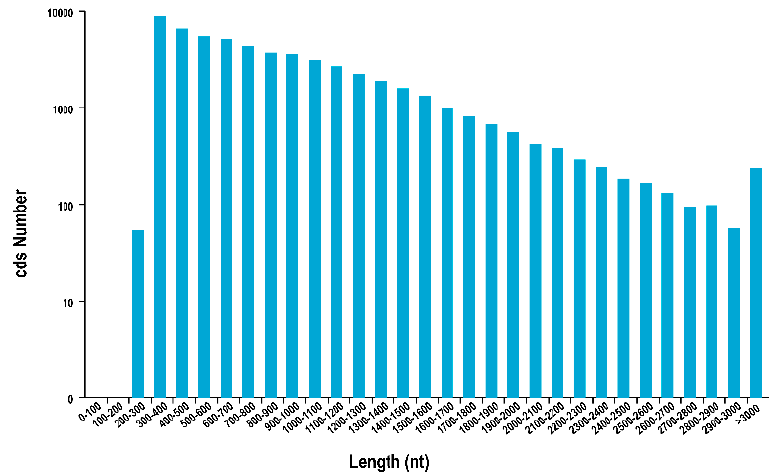
Figure 3. Coding sequence length distribution. The abscissa is the predicted length of CDSs, the left ordinate is the number of transcripts of the CDSs, and the right ordinate is the percentage of transcripts.